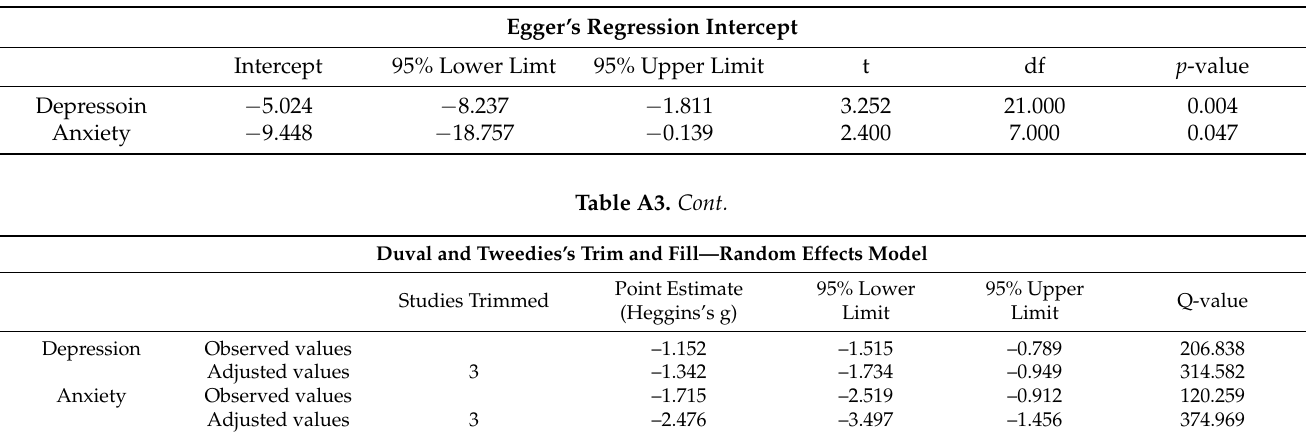
Figure A2. Funnel plot of the effect of depression ( A ) and anxiety ( B ) for publication bias. Table A3. Egger’s regression and Trim and fill